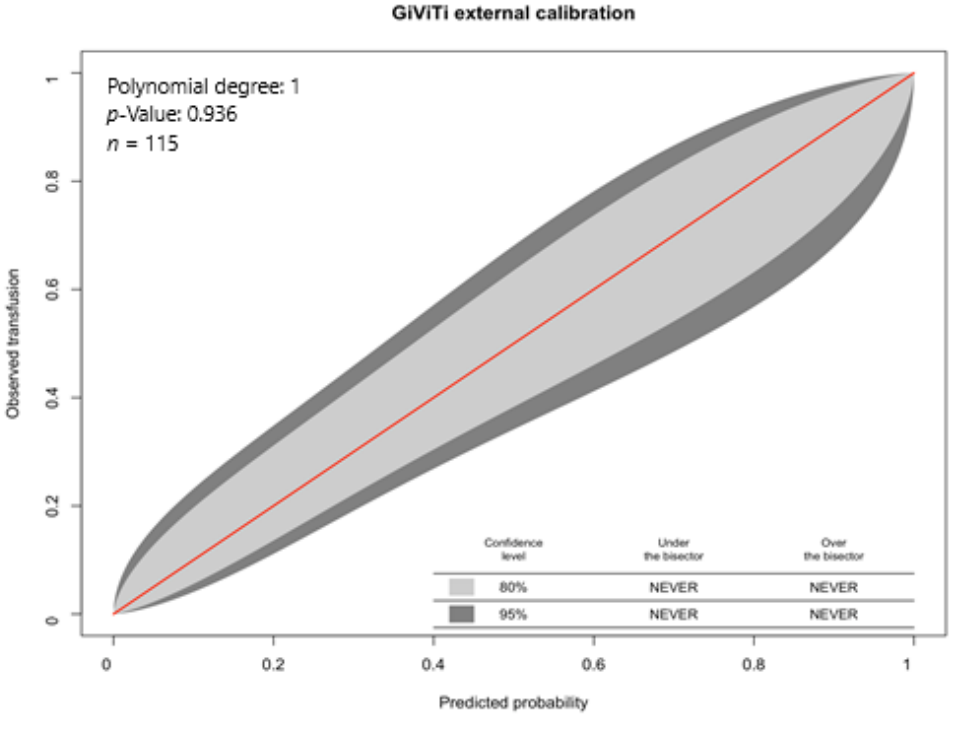
Figure A2. GiViTi external calibration.